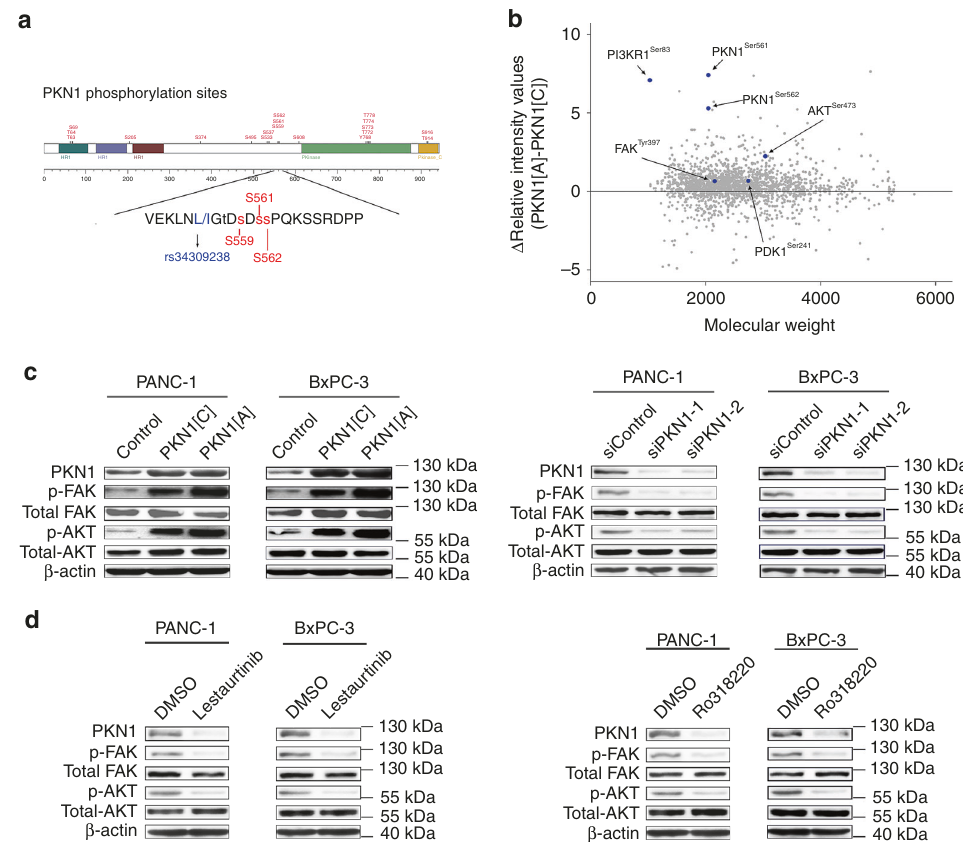
Fig. 2 PKN1 rs34309238 variant in fl uences pancreatic cancer risk by altering the level of phosphorylated PKN1 and thus affecting the FAK/PI3K/AKT signalling pathway. a Protein modi fi cation sites of PKN1. Annotations were obtained from the PhosphoSitePlus database. b Result of the iTRAQ-based comparative proteomics screen. PANC-1 cells were seeded in six-well plates after transfection with PKN1[A], PKN1[C] or control vector. The raw intensity values of cells transfection with PKN1[A] or PKN1[C] were divided by the intensity values of cells transfection with control vector to obtain the relative intensity values. The y axis shows the relative intensity values of cells' transfection with PKN1[A] minus the relative intensity values of cells' transfection with PKN1[C]. The x axis shows the molecular weight of detected peptides. The proteomics screen experiment was repeated independently for two times with similar results. c Levels of phosphorylated FAK and AKT were affected by the PKN1 rs34309238 variant. Cells were seeded in six-well plates after transfection with PKN1[A], PKN1[C] or control vector (left) and PKN1-targeting siRNAs or control siRNA (right). d Levels of phosphorylated FAK and AKT were reduced by the PKN1 inhibitors. Cells were seeded in six-well plates after transfection with PKN1 inhibitors Lestaurtinib and Ro318220 or DMSO